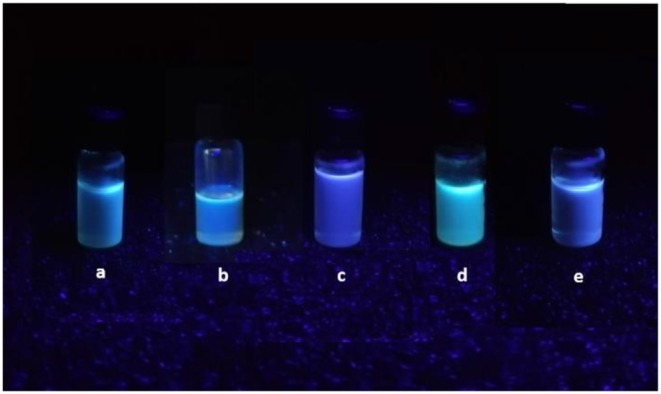
Quinazolinone 6 fluorescence: (a) CH3CN, (b) CH2Cl2, (c) EtOAc, (d) MeOH, (e) acetone.